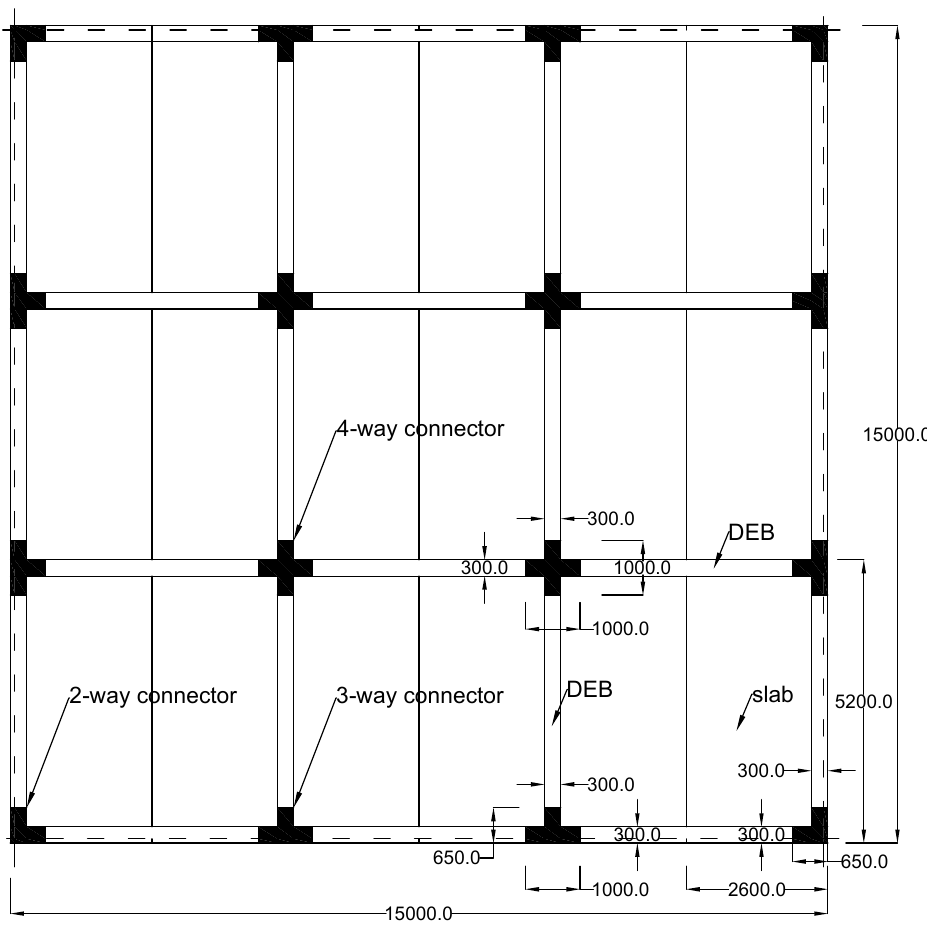
Figure 3. Plan view of the developed prefabricated footing systems (length in